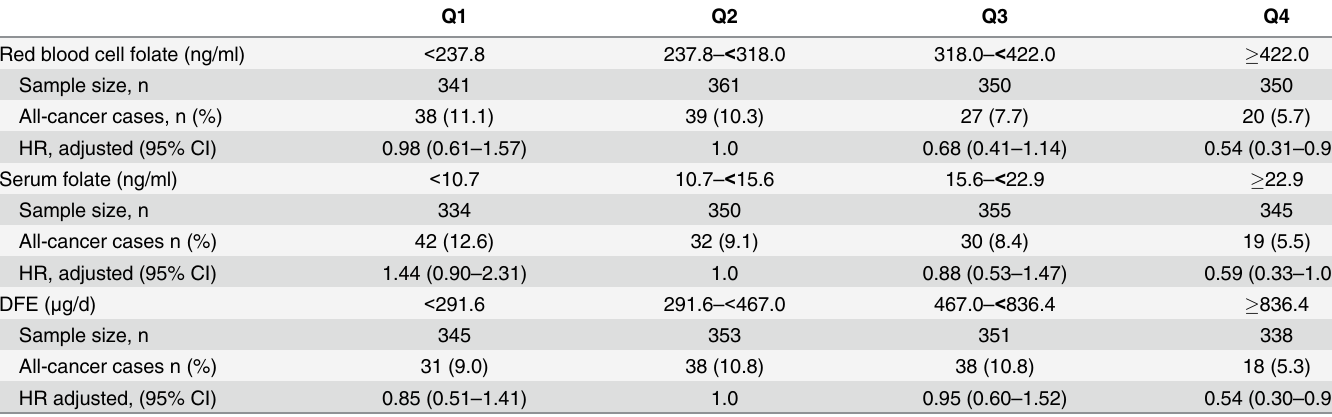
Table 2. Hazard ratios (HR) of overall cancer and 95% confidence intervals (95% CI) by quartiles (Q) of red blood cell (RBC) folate, serum folate, and dietary folate equivalents (DFE) 1,2 , NHANES 1999 – 2002.